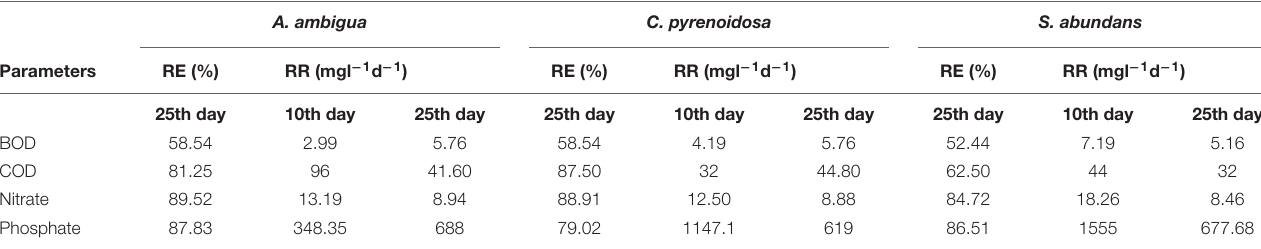
TABLE 3 | Reduction efficiency (RE) and removal rate (RR) of A. ambigua, C. pyrenoidosa, and S. abundans in 3:1 ratio of